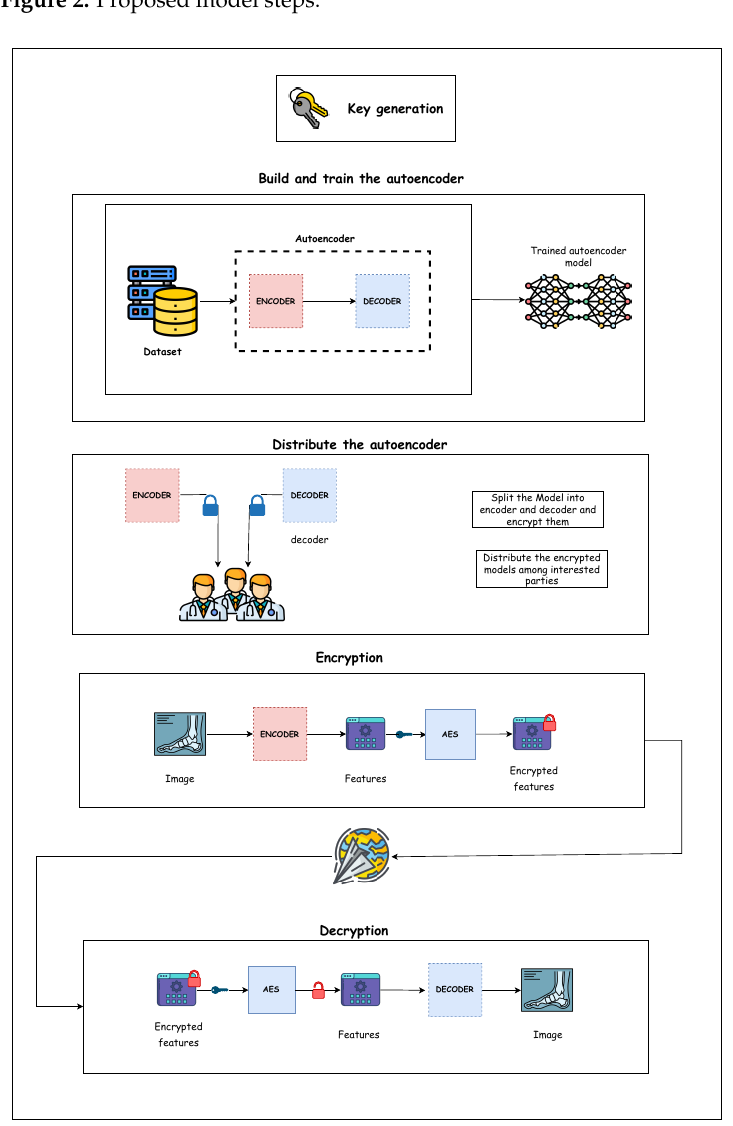
Figure 3. Proposed model